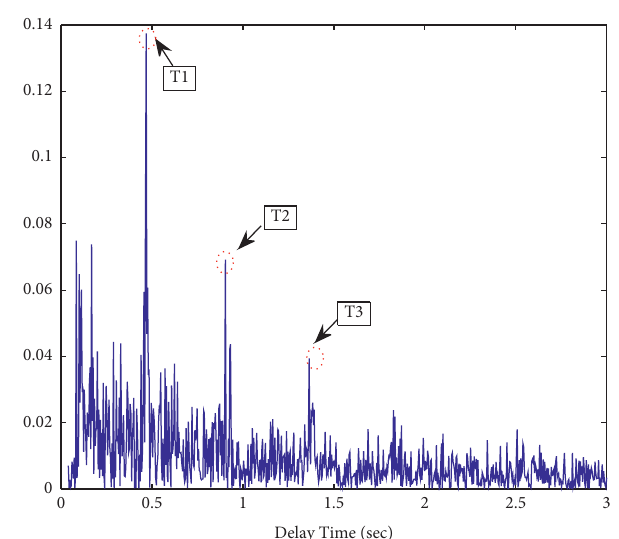
Figure 3: Delay time of the underwater explosion on November 10, 2008, recorded by the H08S